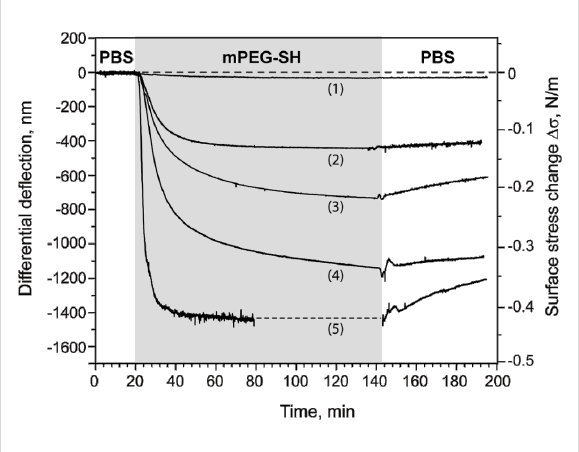
Figure 3: Concentration-dependent grafting of mPEG–SH on Au: overlay view of five binding curves. The grey area indicates the period of injection of mPEG–SH solution. The binding curves were obtained at mPEG–SH concentrations of 0.5 μ M (1), 10 μ M (2), 50 μ M (3), 100 μ M (4) and 500 μ M (5). Each curve was obtained by subtracting the response of the reference cantilevers from at least two sensing cantilevers from within the same array. The resulting five curves were further normalized with respect to the mechanical properties of the cantilevers used (see Material and Methods section). The dashed line in the curve (5) is the extrapolated saturation signal.